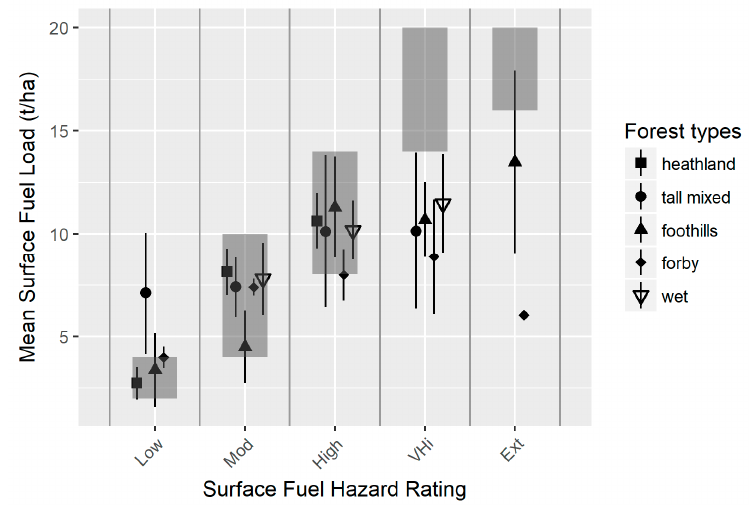
Figure 1. Mean destructively sampled surface fuel loads (t/ha) (symbols) with 95% confidence intervals by fuel hazard ratings: Low, Moderate (Mod), High, Very High (VHi) and Extreme (Ext). Grey bars represent the range of converted fuel loads from the Overall Fuel Hazard Guide .